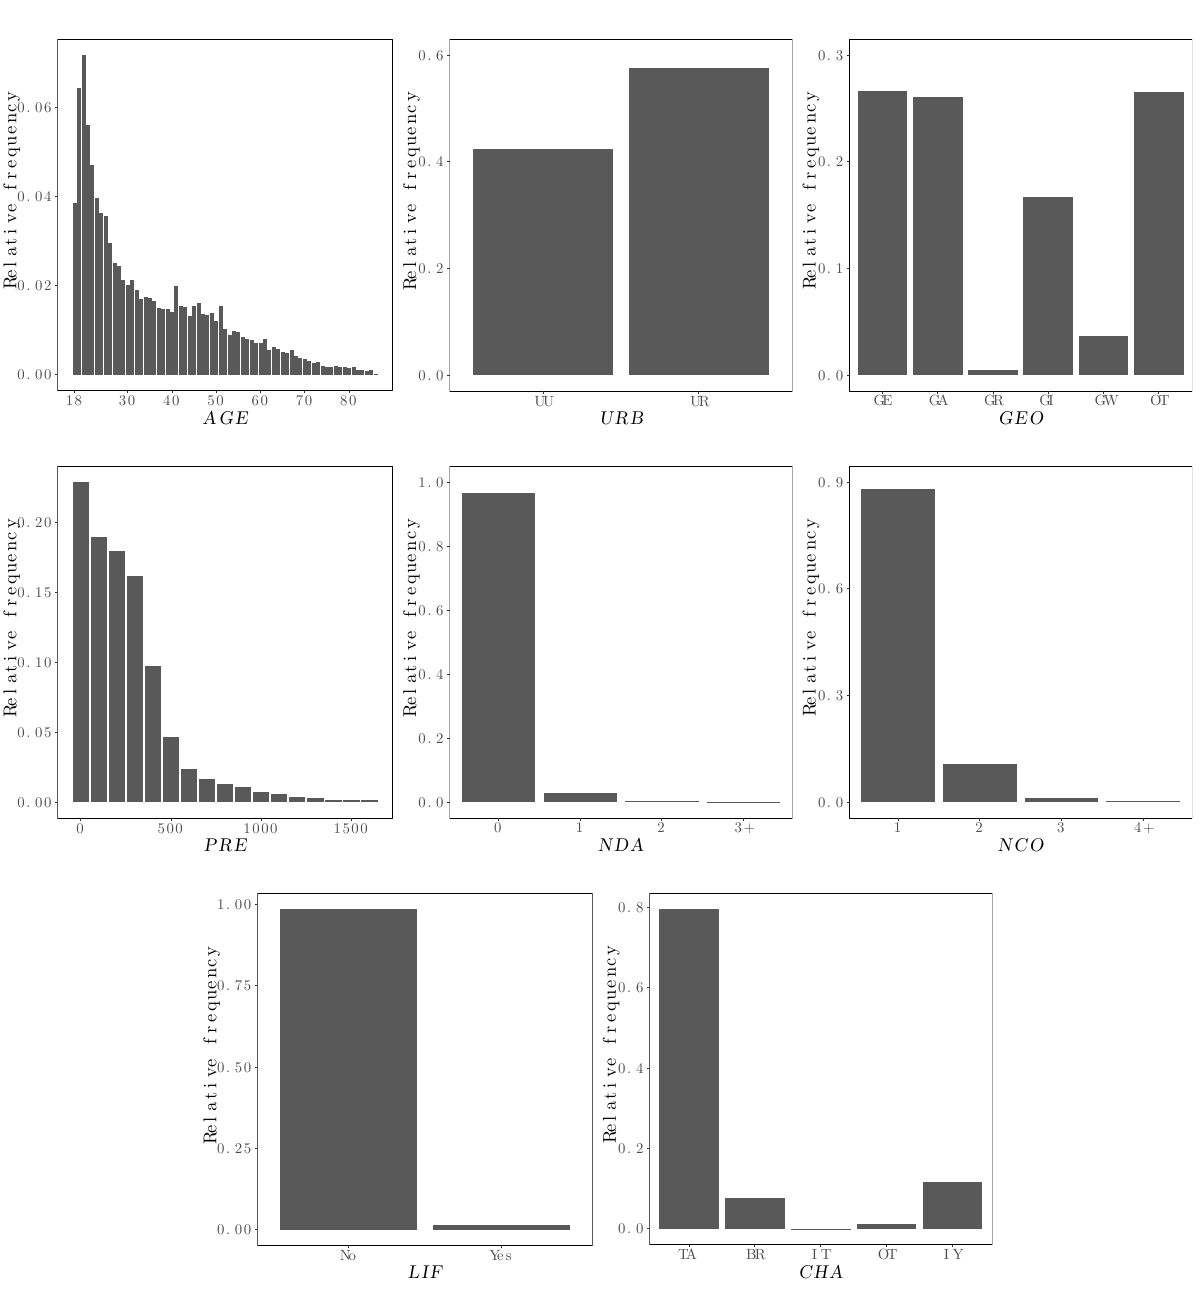
Figure 5. Illustration of the relative frequencies along covariates in the HL